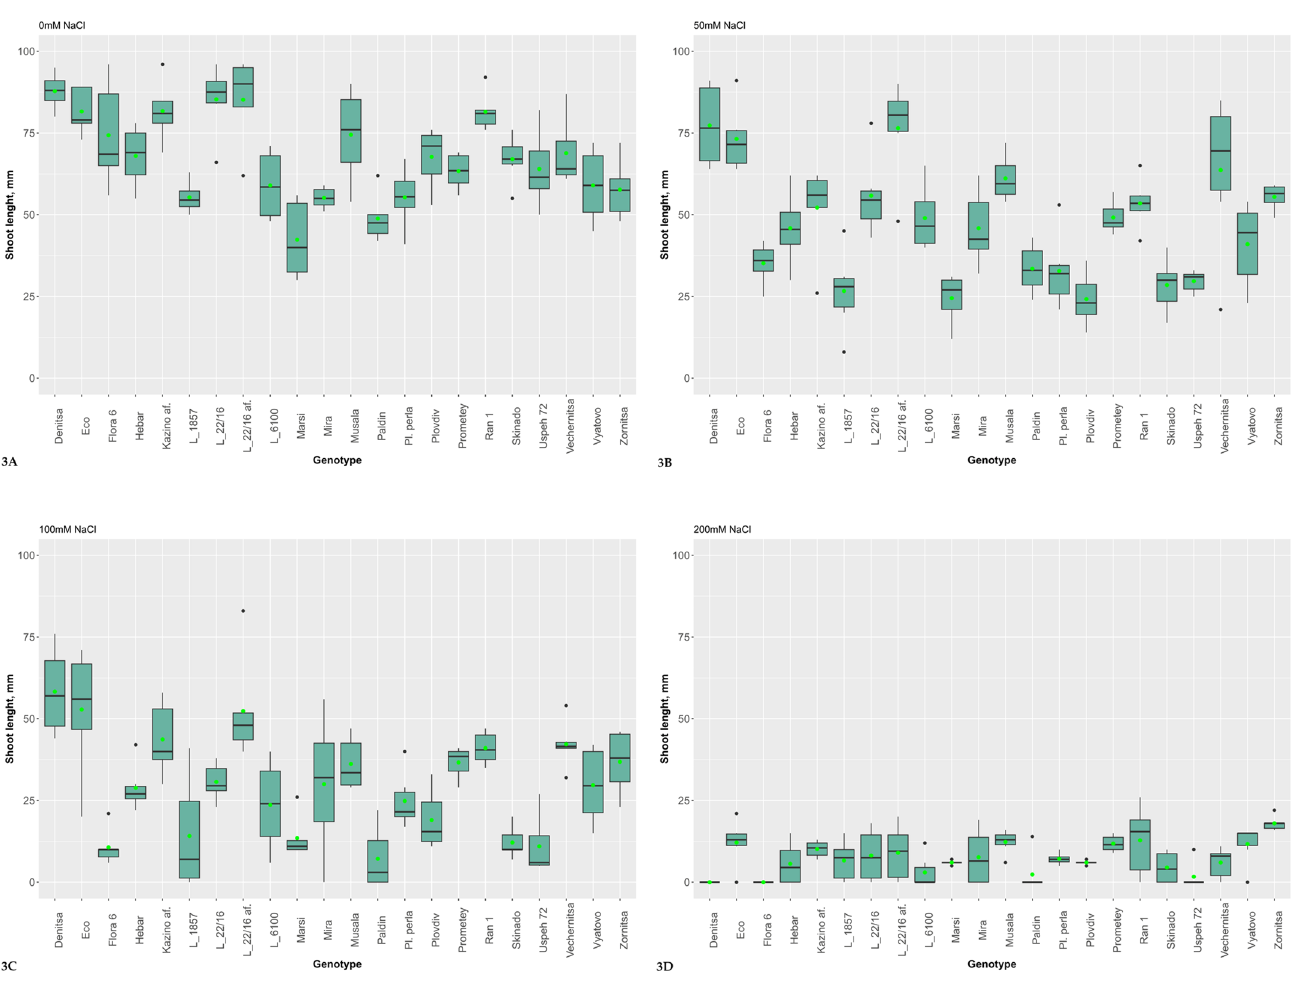
Figure 3. Shoot length (mm) of 22 garden pea genotypes as influenced by the concentration of NaCl in nutrient medium in vitro after 14 days of cultivation. ( A ) 0 mM NaCl; ( B ) 50 mM NaCl; ( C ) 100 mM NaCl; ( D ) 200 mM NaCl.